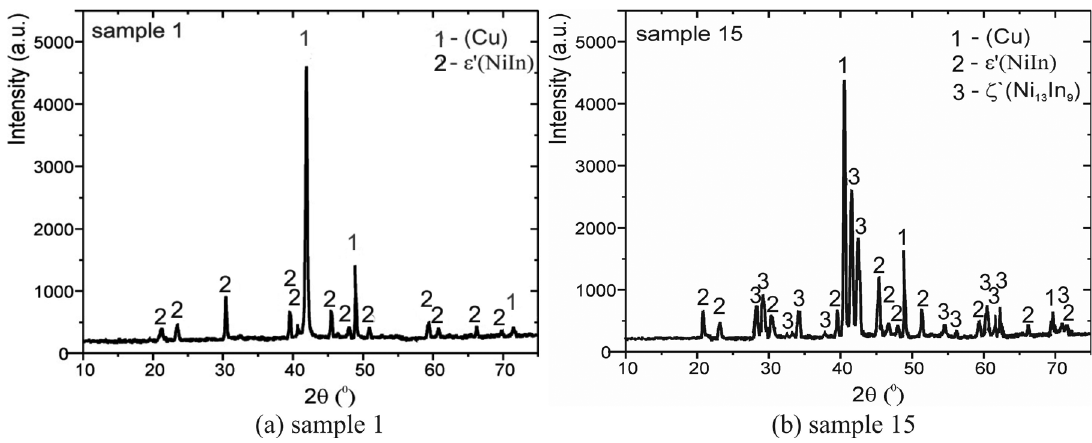
Figure 3. XRD patterns of the studied alloys: a) sample 1 and b) sample 15